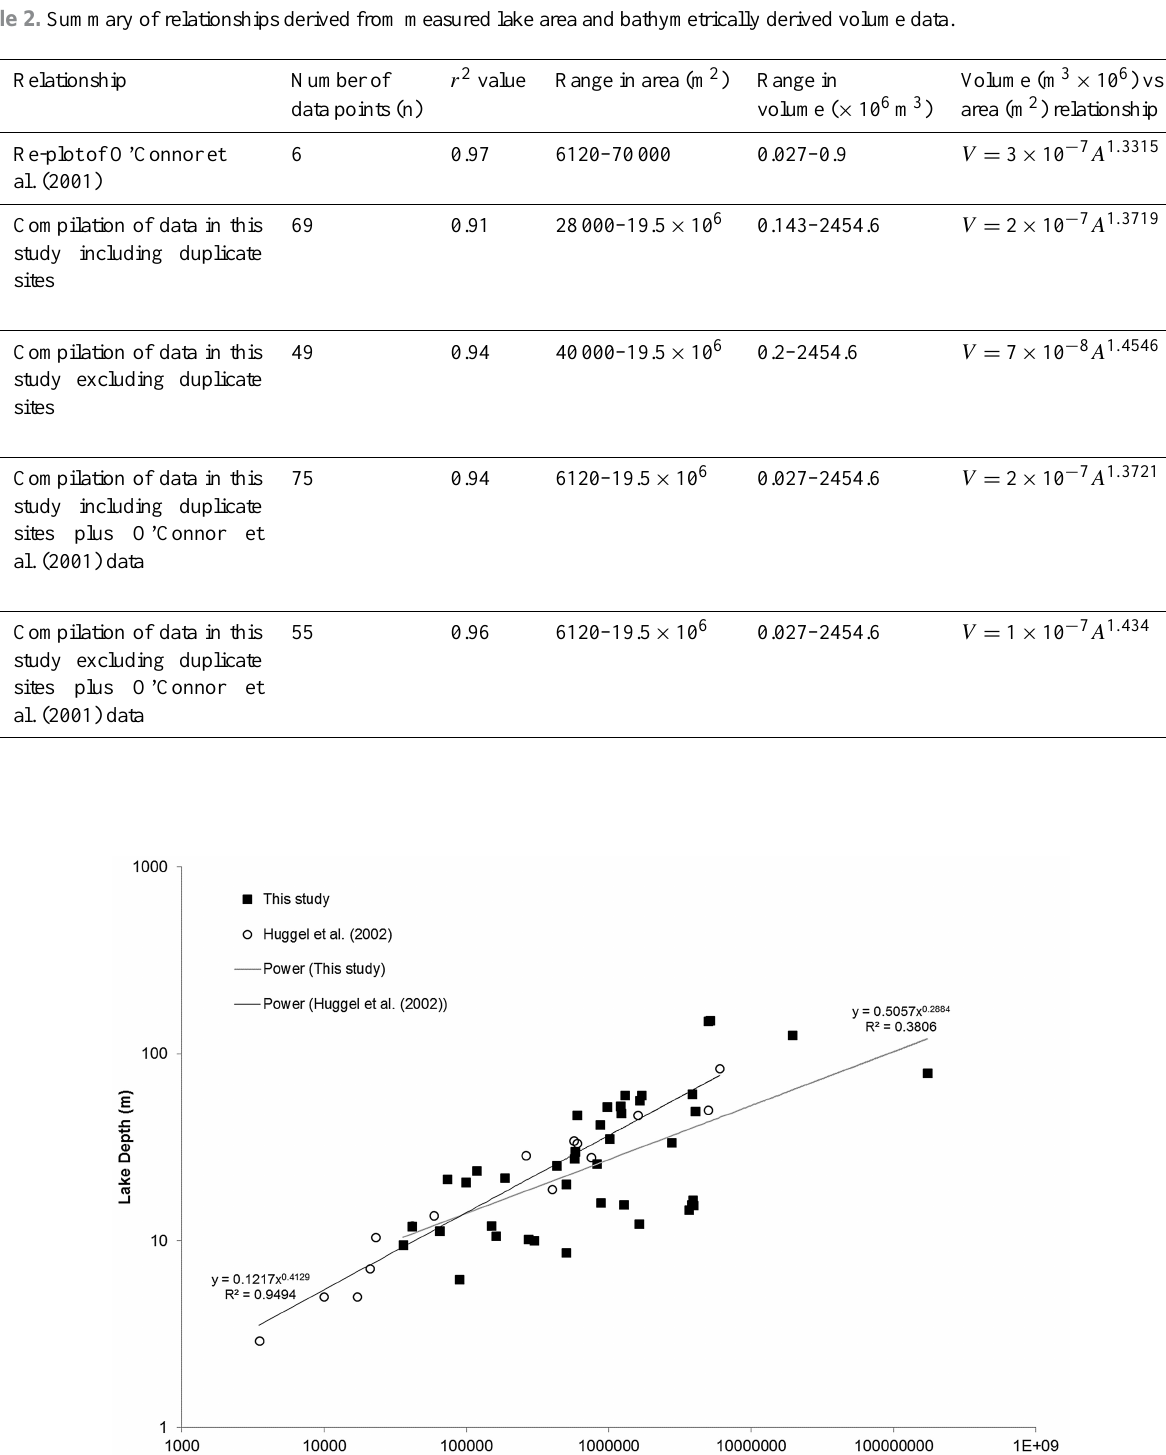
Earth Surf. Dynam., 3, 559–575,